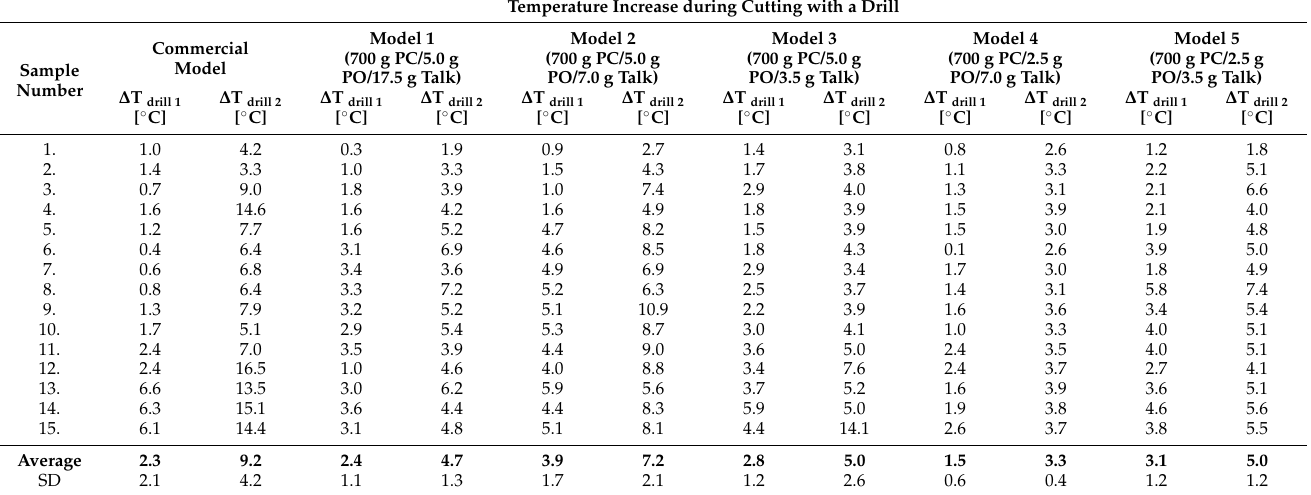
Table 3. The temperature change during drilling of holes for all tested materials. Materials were dried before drilling. A total of 15 wells were made in each material. The difference ( ∆ T) between the highest temperature obtained in the drilling process and the initial temperature of the analyzed surface was calculated for drill 1 and drill 2. Standard divination (SD) was also